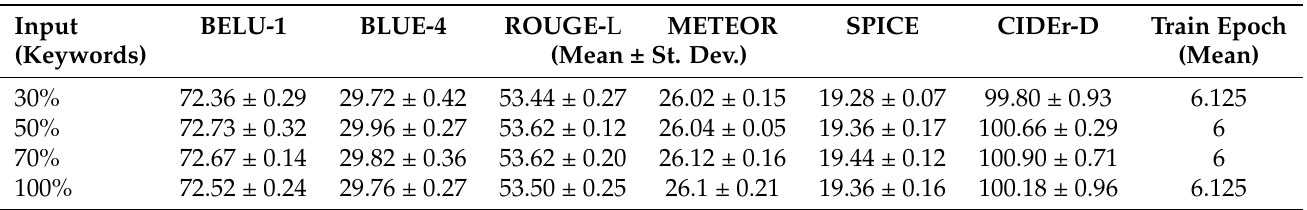
Table 6. Performance comparison according to keyword input percentage. Training eight times for each model.